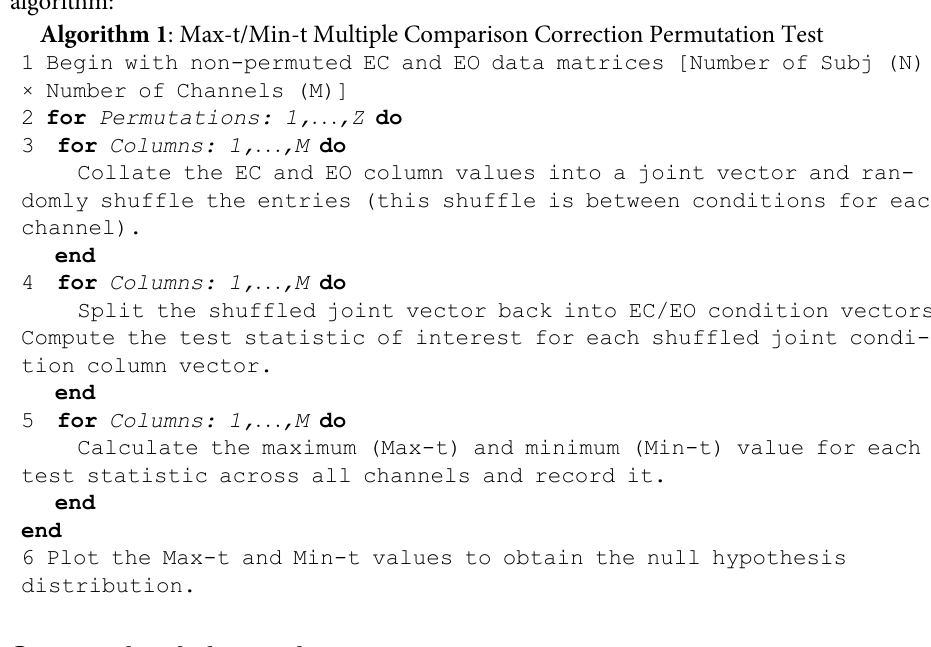
S1 Fig. Area of cp ( γ ) between EC and EO conditions. Empirical demonstration of the equiva- lence of the constant c in Eq 14 between EC and EO